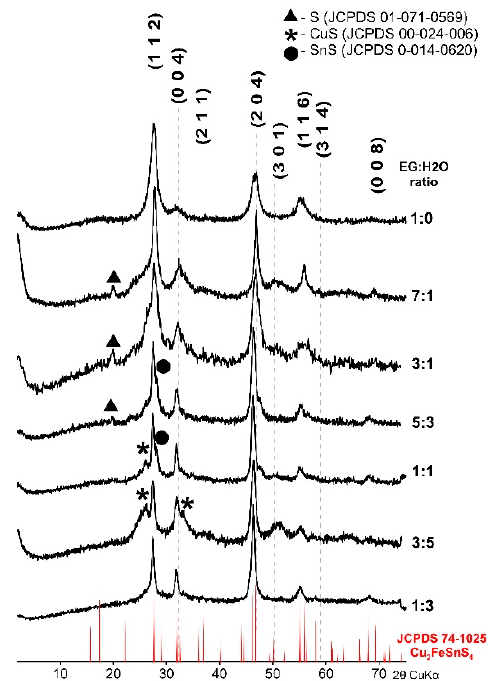
Figure 1. Powder X-ray diffraction pattern of Cu 2 FeSnS 4 (CFTS) nanoparticles synthesized at various EG:H 2 O ratios with the stannite standard positions marked at the bottom. In some samples impurities were detected as artifacts of an incomplete reaction. The optimal EG:H 2 O ratio is 7:1.